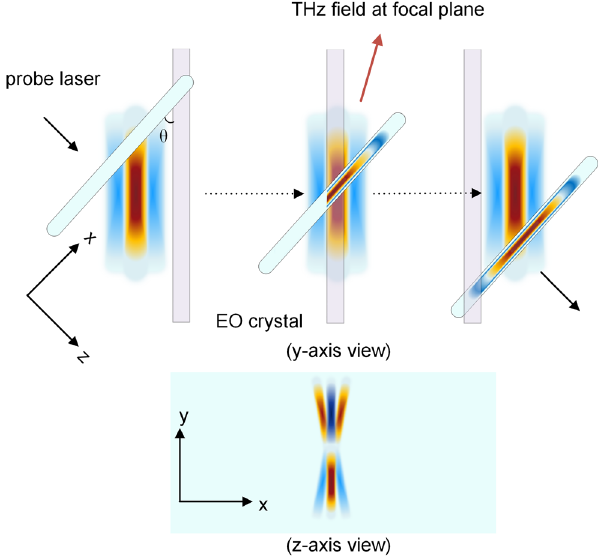
FIG. 1. Schematic description of the EO spatial decoding method. The y-axis view shows three instants during the course of the measurement. The lavender object represents the EO crystal. The colorful object represents the THz electric field distribution at the focal plane. The aqua object represents a probe laser pulse passing through the EO crystal with an angle θ relative to the THz pulse travel direction. Hence, a different cross section of the probe laser was modulated by the THz field with different arrival time in the EO crystal. The z-axis view shows the modulated transverse spatial profile of the probe